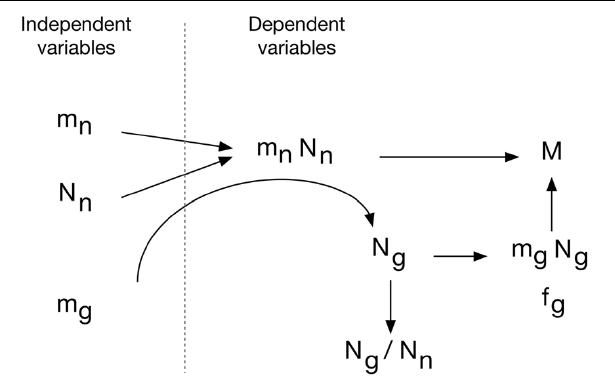
FIGURE 15 | Evo-devo model of brain tissue construction. Independent variables are average neuronal cell mass ( m n ), average glial cell mass ( m g ) and number of neurons ( N n ). The product m n .N n is the total neuronal mass in the tissue, which is then invaded by a number of glial cells N g that depends on small variations in m g to create a total glial mass that matches the total neuronal mass in the tissue, depending on the ratio of neuronal cell mass per glial cell that we propose to be determined by m g . This results in a certain neuronal mass fraction, f n , and corresponding glial mass fraction, f g . In evolution, variations in N n , linked or not to variations in m n , would yield structures of different masses whose glia/neuron ratios depend on m n and its ratio to m g . Additionally, smaller variations inmg lead to variations in the glial mass fraction, f g , and in the neuron/glial mass